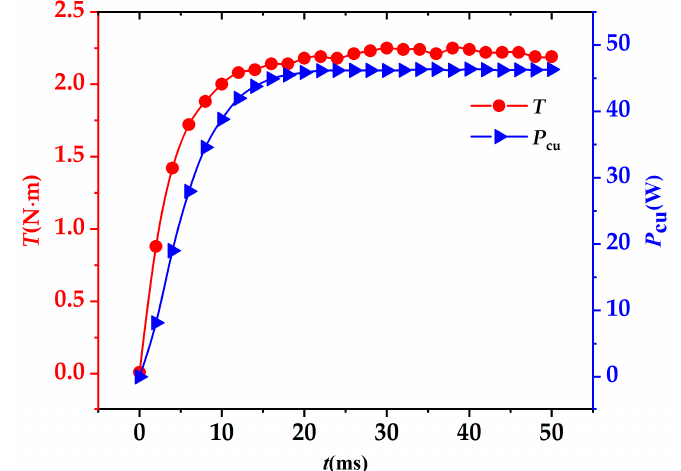
Figure 4. Simulation results in torque and eddy current loss of the copper